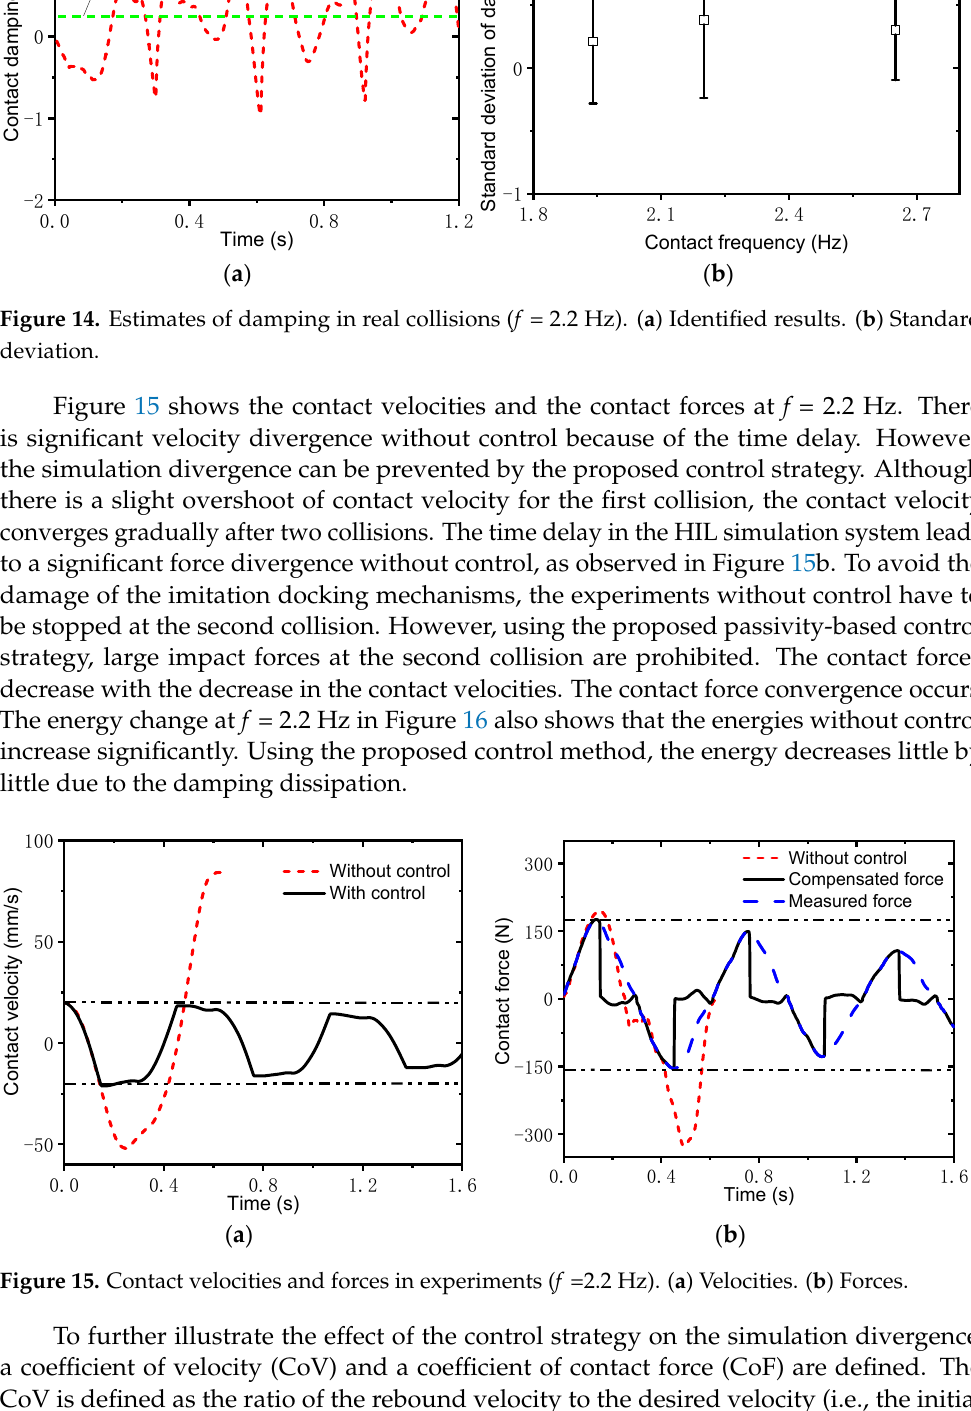
Figure 16. Energy in experiments ( f = 2.2 Hz). To further illustrate the effect of the control strategy on the simulation divergence, a coefficient of velocity (CoV) and a coefficient of contact force (CoF) are defined. The CoV is defined as the ratio of the rebound velocity to the desired velocity (i.e., the initial veloc- ity) [17]. During practical contact experiments, both the theoretical contact stiffness and damping are unknown. Thus, the desired contact force cannot be obtained in practical experiments. Therefore, the CoF is defined as the ratio of the maximum contact force dur- ing each collision to the maximum contact force during the first collision. Figure 17 shows the CoVs and CoFs during the experiments with respect to different contact frequencies. It is found that the convergence phenomena occur more obviously with the increase in contact frequency. Meanwhile, contact forces for different contact frequencies show simi- lar changes to the contact velocities. Accordingly, the proposed control strategy can deal with the simulation divergence for different contact frequencies.